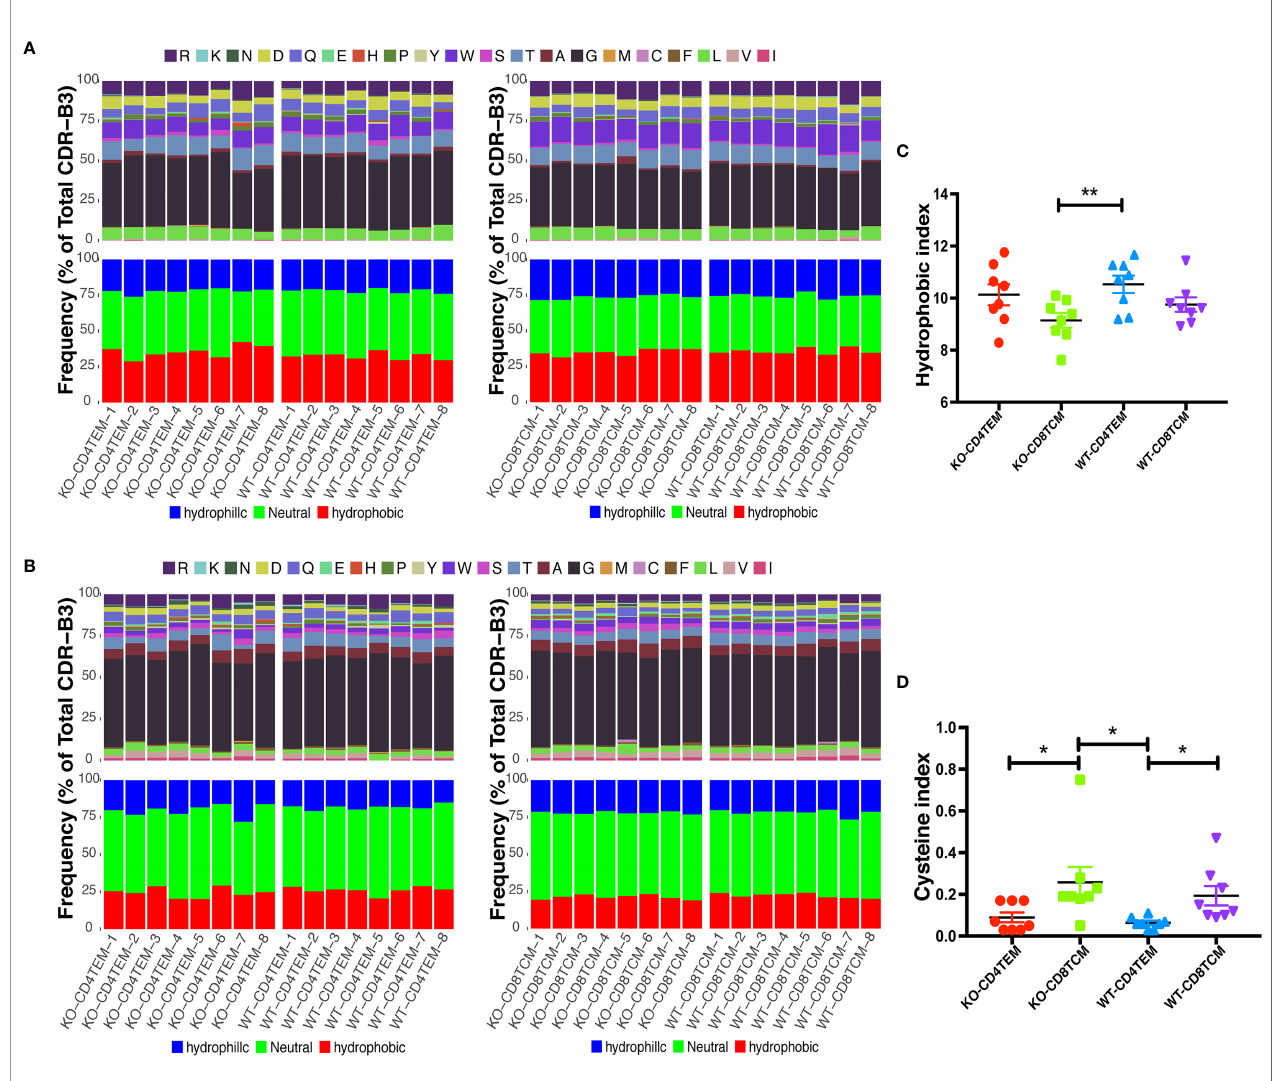
FIGURE 6 | Hydrophobicity of amino acids (aa) in CDR3 b repertoires of CD4 + TEM cells or CD8 + TCM cells from WT and KO chimeras. Composition of aa residues at positions 6 (A) and 7 (B) of the 13 aa-long CDR3 b . Hydrophobic index (C) and cysteine index (D) in CDR3 b repertoires. *p < 0.05; **p <